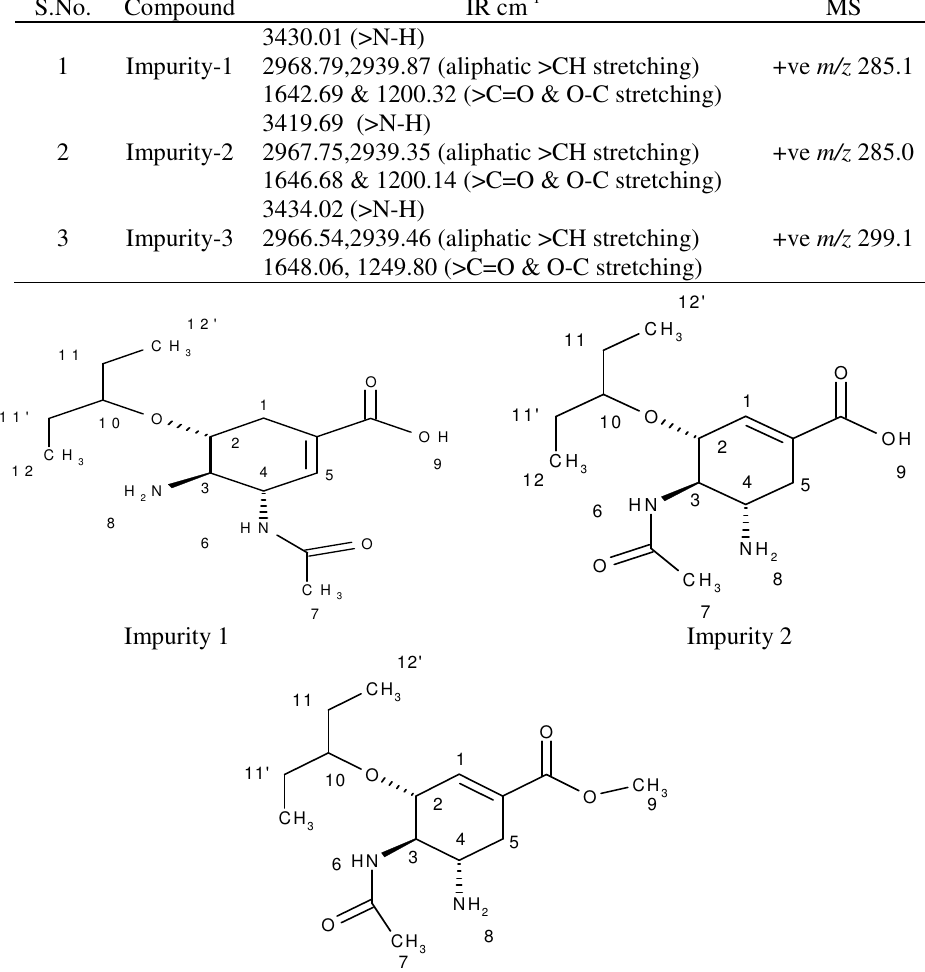
Table 1. IR and mass spectral data of impurities 1, 2 &